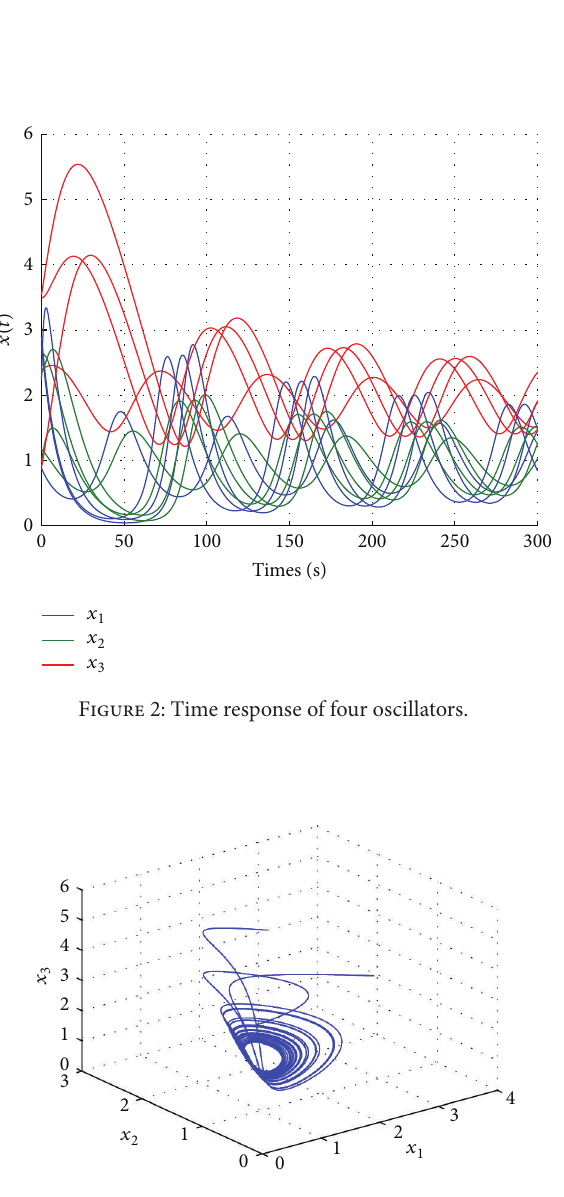
Figure 3: Limit cycle of the oscillators in phase space.